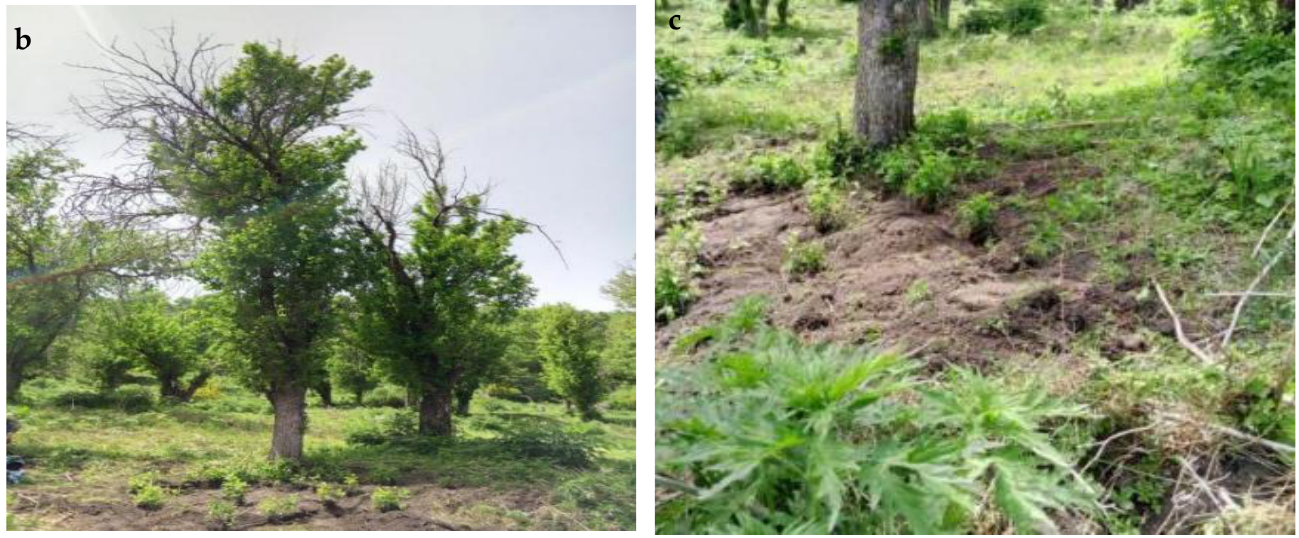
Figure 1. The location of the study area and sampling points. ( a ) Locations of sampling sites; ( b ) General view of wild apple forests; ( c ) Distribution of Malus sieversii root sprouts under the tree canopy.